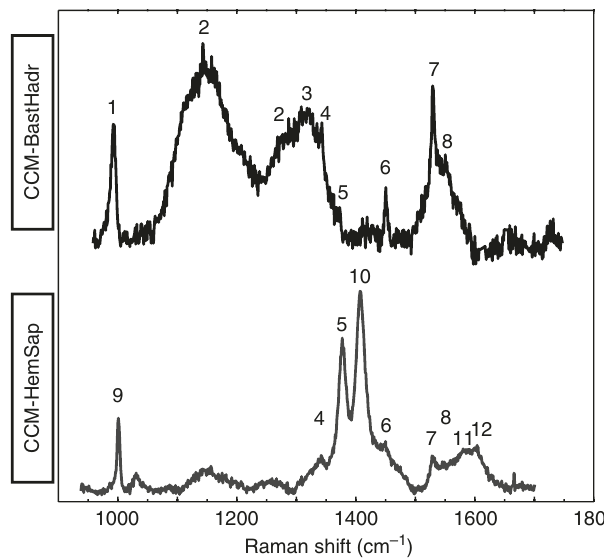
Fig. 5 Raman spectra for CCM-BastHadr and CCM-HemSap assemblages and assignment of the different bands. 1: Hydroandradite, 2: Cr 3 + luminescence, 3: CH 2 wagging, 4: CH deformation, 5: CH 3 in aliphatic compounds (CH 3 symmetric deformation), 6: CH 2 and CH 3 in aliphatic chains (bending, scissoring, antisymmetric stretching), 7: Aliphatic COOH, 8: COO − antisymmetric stretching, 9: C-C aromatic or phenyl, 10: COO − symmetric stretching, 11: C = C aromatic, 12: C-C aromatic ring stretching. Assignment was done using refs. 28, 29 . For the exact position of the bands see Supplementary Table